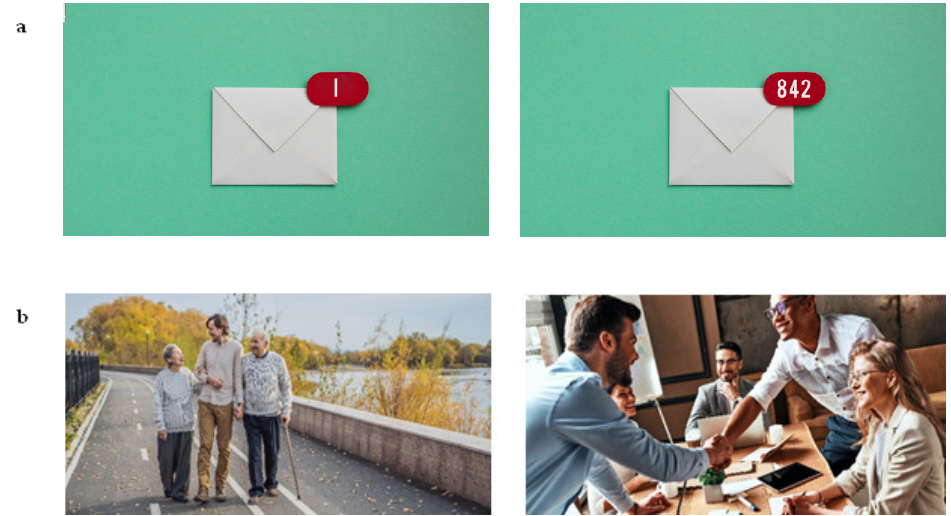
Figure 2. Examples of single-trait pairs. ( a ) is designed to measure the ““I like to tidy up” statement from the orderliness facet of conscientiousness. ( b ) is designed to measure the “I look at the bright side of life” statement from the cheerfulness facet of extraversion.